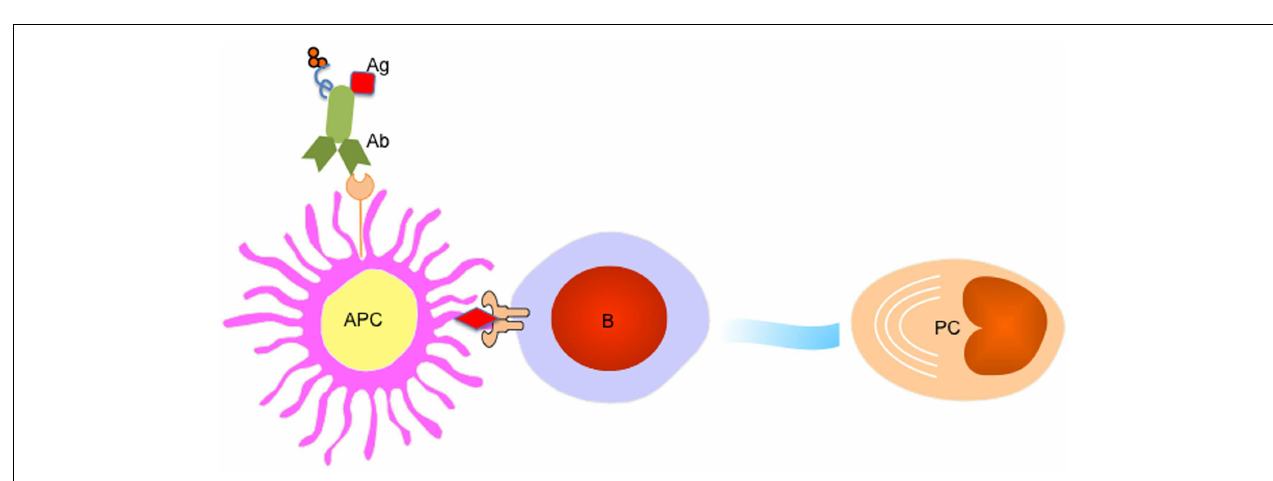
processes Ag to B cells to trigger PC differentiation. An adjuvant (for example IP-10) could be linked to the fusion protein to provide additional signals for PC generation and maintenance.